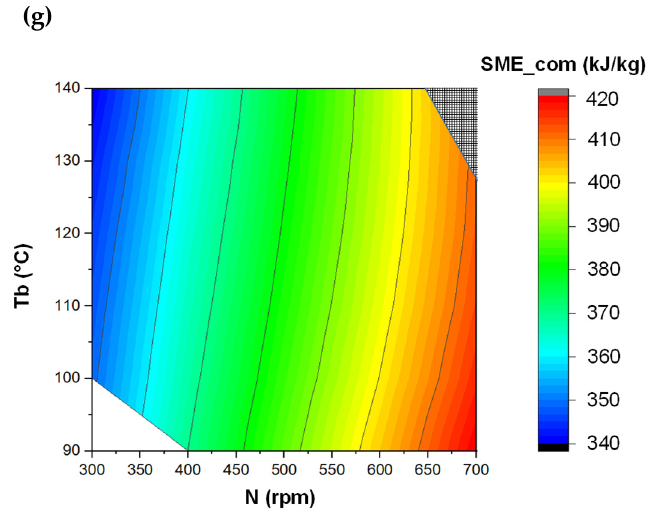
Figure 8. Application of extrusion simulation in the design of wheat snacks. Feed: Wheat flour enriched with low bran content. Step 1. Variation of water solubility index of starch (WSIstarch) with SME_com ( a ), and variation of sectional expansion index (SEI) ( b ) and cell density (NC) ( c , d ) with T_com and η _com. In ( a ), the arrows indicate the lower limit of targets, while in ( c ), they indicate lower and upper bounds. Step 2. Creation of extruder operating chart and determination of ex- trusion parameters range. Fixed operating conditions: MC = 22% and Q = 20 kg/h. The hatched area in ( e – g ) indicate the range of extrusion conditions (N, Tb) leading to T_com and SME_com according to the goals: a porous and expanded structure (1000 ≤ NC ≤ 2000 and SEI ≥ 4.5); and 50% ≤ WSI starch ≤